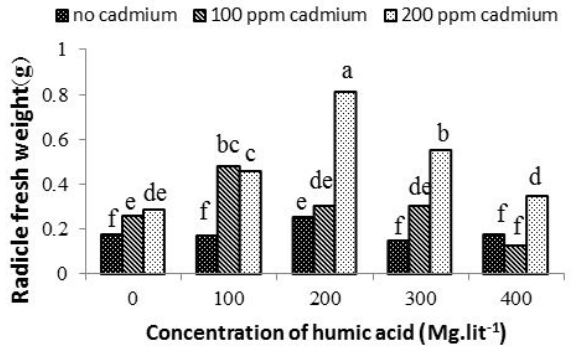
Fig. 3. Effect of humic acid and cadmium concentration on the